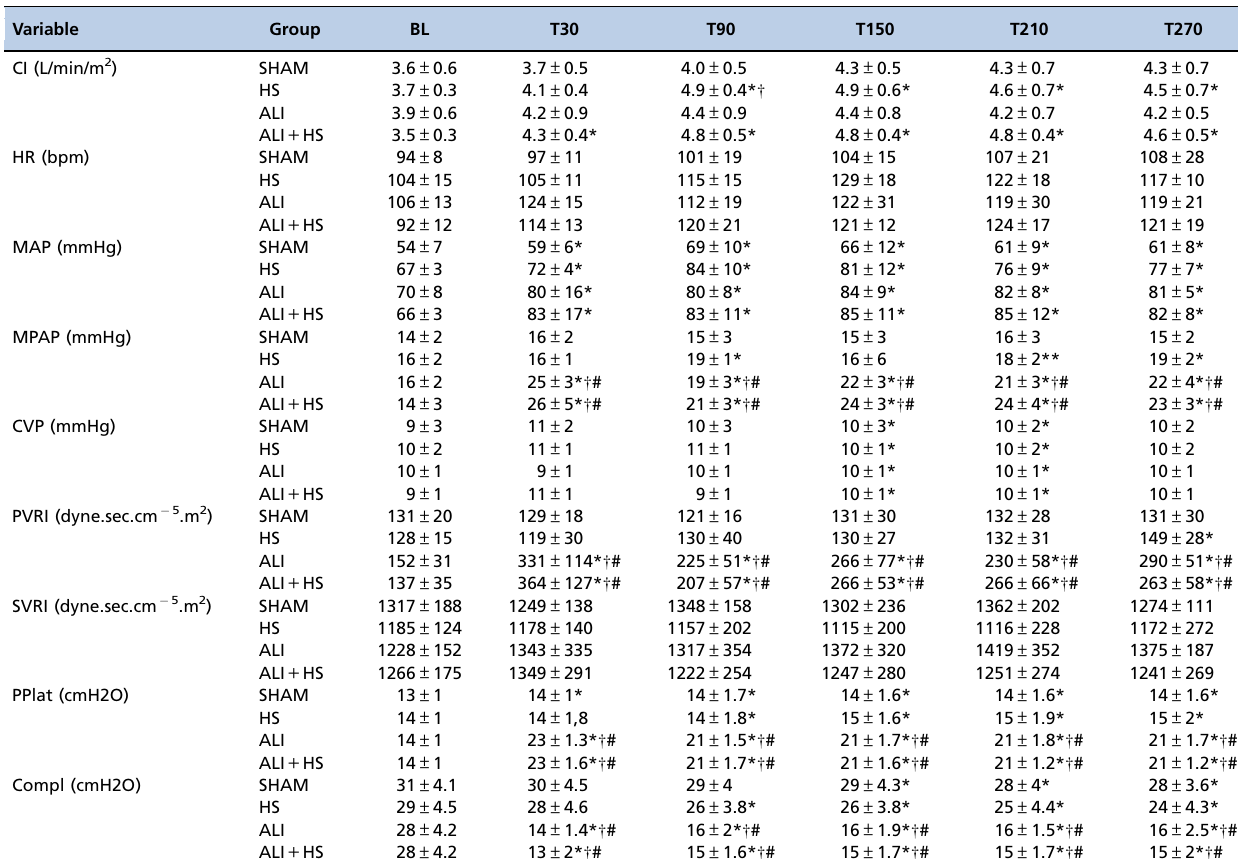
Table 1 - Hemodynamics and respiratory variables in the control (SHAM and hypertonic saline) and acid lesion (acute lung injury and acute lung injury + hypertonic saline) groups.